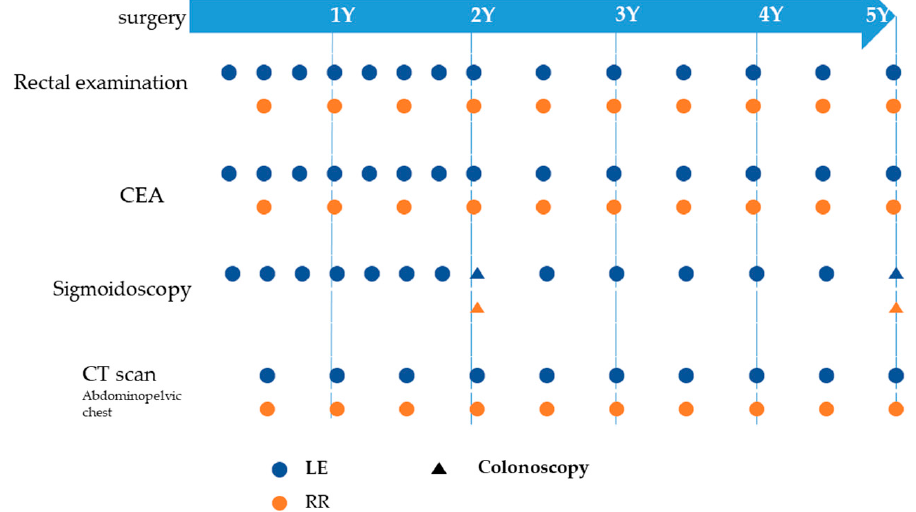
Figure 3. Scheme of surveillance protocol. Colonoscopy was performed every 2 or 3 years. RR, radical resection; LE, local excision; CT, computed tomography .